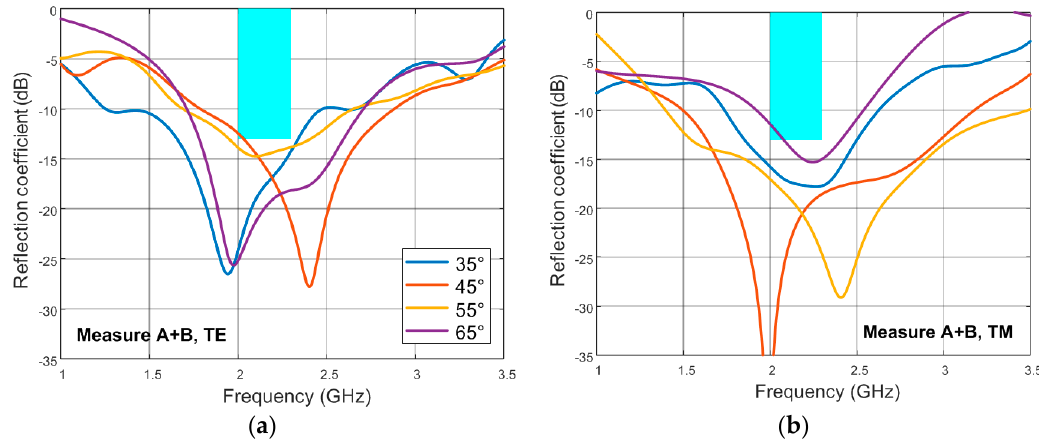
Figure 11. Bistatic measurement of the sectorial absorber A + B at various angles for TE ( a ) and TM ( b ) polarizations. The rectangle features an objective of − 13 dB on the [2 GHz, 2.3 GHz] band.